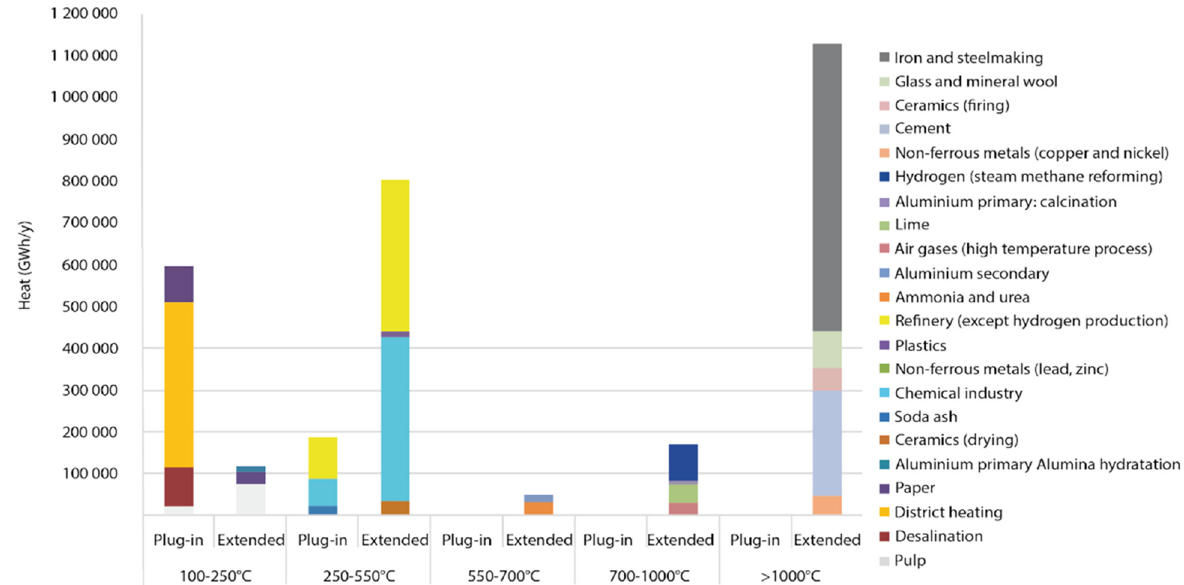
Fig. 2. Distribution of the heat market by temperature class and sector